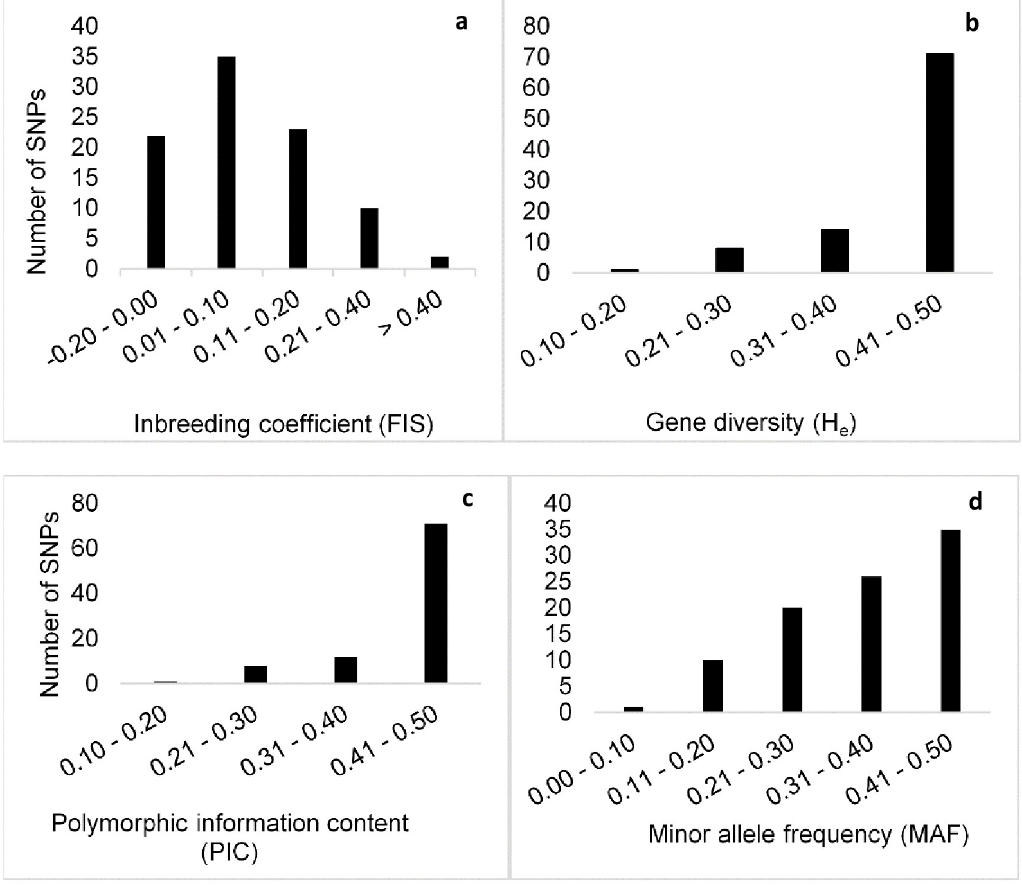
Fig 1. Distribution of the 92 SNPs estimated for all 188 maize genotypes for (a) Inbreeding coefficient, (b) Gene diversity, (c) Polymorphic information content and (d) Minor allele frequency.